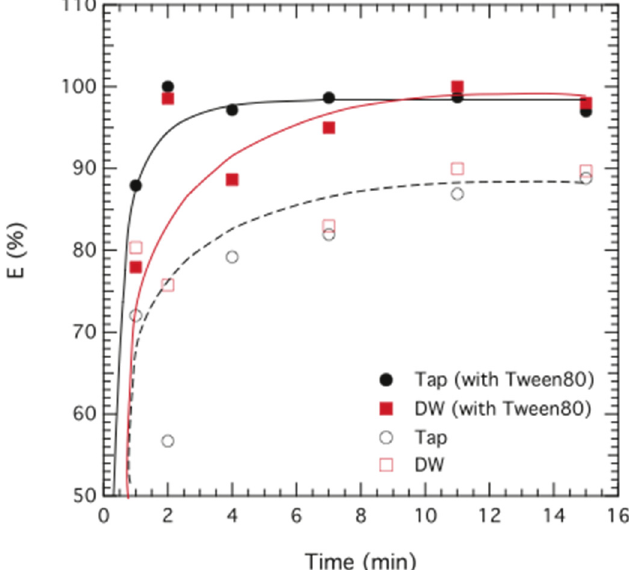
Figure 6. Extraction of chromium as a function of time. Data are plotted for ELM formulations containing 3 wt% Span 80, 1 wt% butanol and 0.35 wt% TOMAC, without Tween 80 (hollow symbols) and with 1 wt% Tween 80 (filled symbols) prepared in distilled water (DW; ■ ) and tap-water (Tap; ▲ ). The initial concentration of chromium was 95 ppm (DW) and 104 ppm